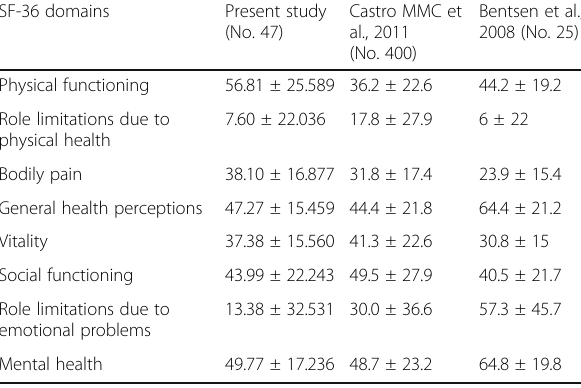
Table 4 comparison of SF-36 results with other studies SF-36 domains Present study